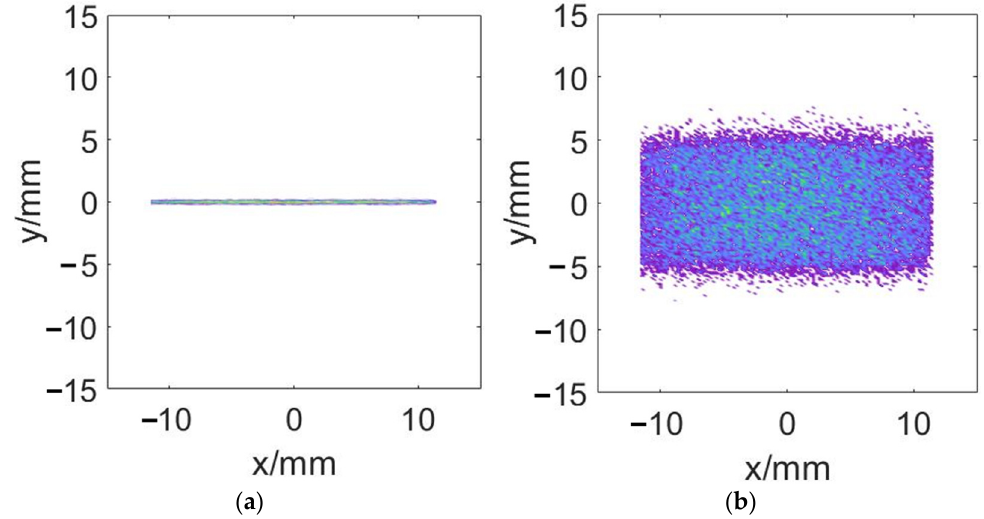
Figure 6. Electron beam profile at the screen in the GPT simulation. ( a ) Deflecting cavity is off; ( b ) Deflecting cavity is on.